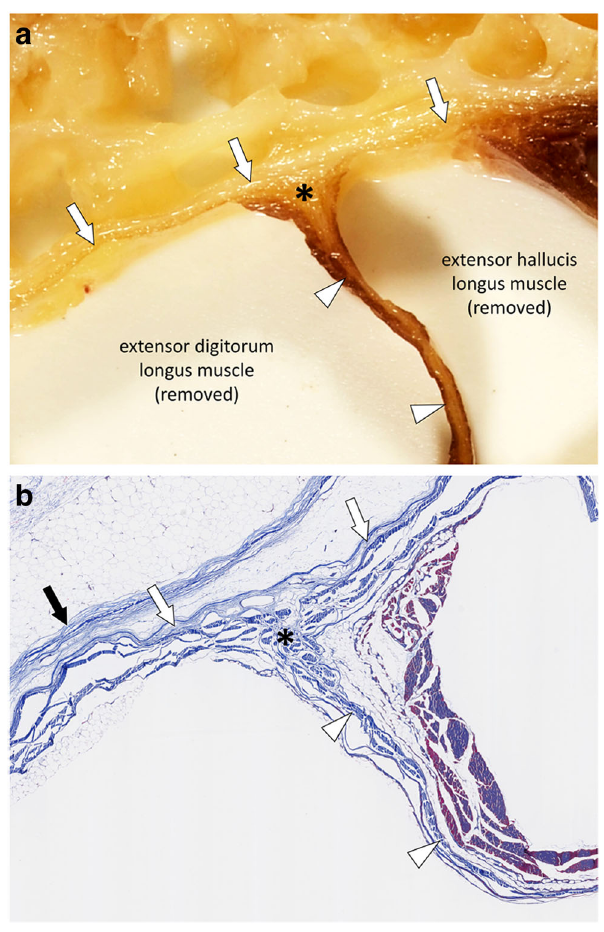
Fig. 5 a Close-up photograph and ( b ) photograph of the corresponding microscopic image (Masson ’ s trichrome stain) of the anterior compart- ment of the leg (red square in Fig. 1). The deep peripheral fascia (white arrows) and the deep intermuscular fascia (arrowheads) are in continuity (asterisks). The fascia superficialis (black arrow) closely overlies the deep peripheral